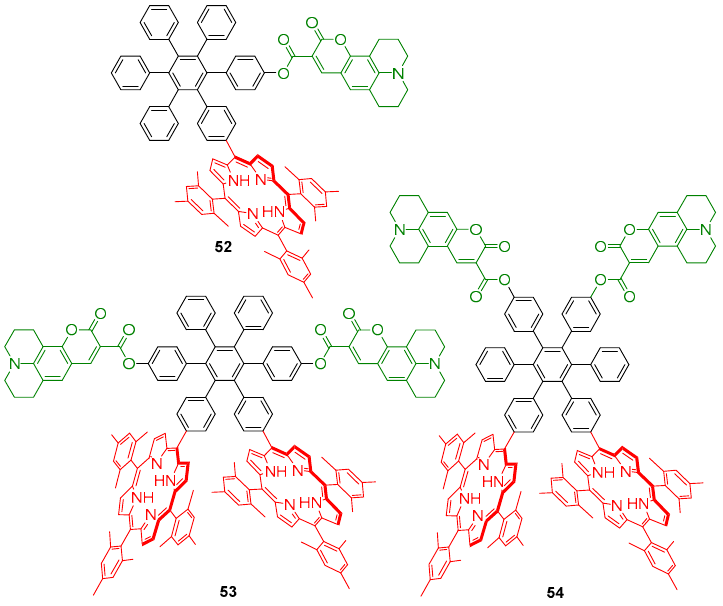
Figure 3. Model compounds of artificial photosynthetic reaction centers [62].